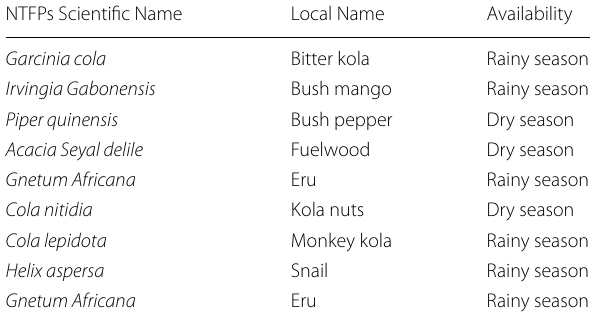
Table 6 NTFPs and their availability